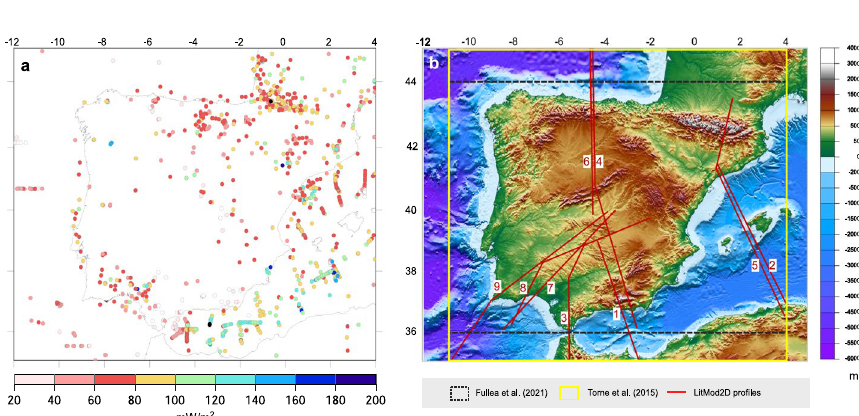
Fig. 3 a Available surface heat flux (SHF) data compiled from Foucher et al. (1992), Marzán (2000), Poort et al. (2020), and the International Heat Flow Commission global data set (https:// www. ihfc‑ iugg. org/ produ cts/ global‑ heat‑ flow‑ datab ase). Colored dots indicate location of measurements. b Location of thermal models carried out on the Iberian Peninsula and its adjacent margins, for which the results are summarized in this study. Thick red lines show location of 2D profiles. Thick yellow and dashed grey lines show location of regional models. 2D profiles: 1 and 2—Kumar et al. (2021); 3—Jiménez‑Munt et al. (2019); 4—Carballo et al. (2015a); 5—Carballo et al. (2015b); 6—Pedreira et al. (2015); 7 and 8—Palomeras et al. (2011); 9—Fernàndez et al.